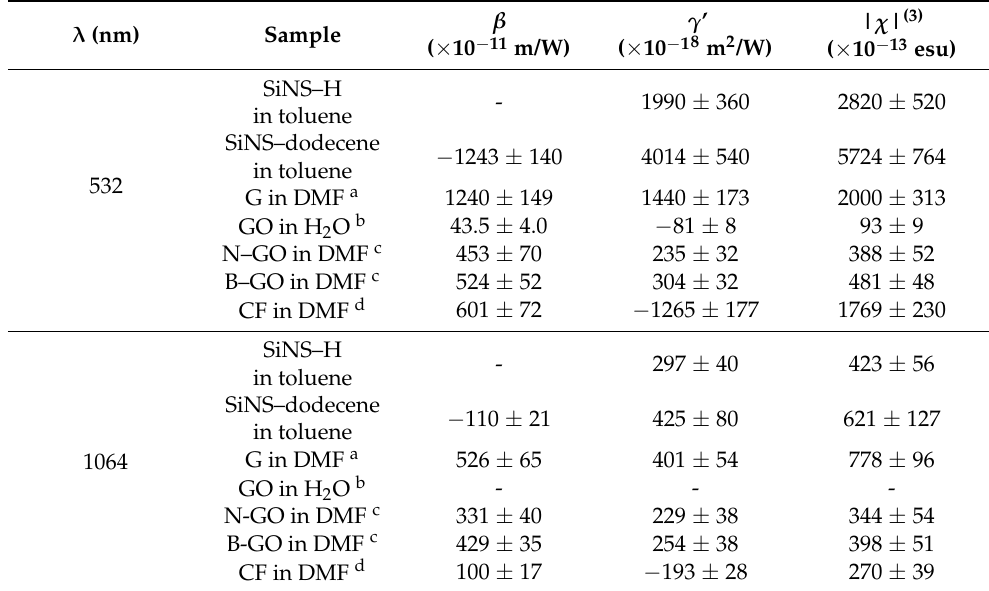
Table 1. NLO parameters of SiNS–H, SiNS–dodecene, and graphene (G) determined under 532 nm and 1064 nm laser excitation for 4